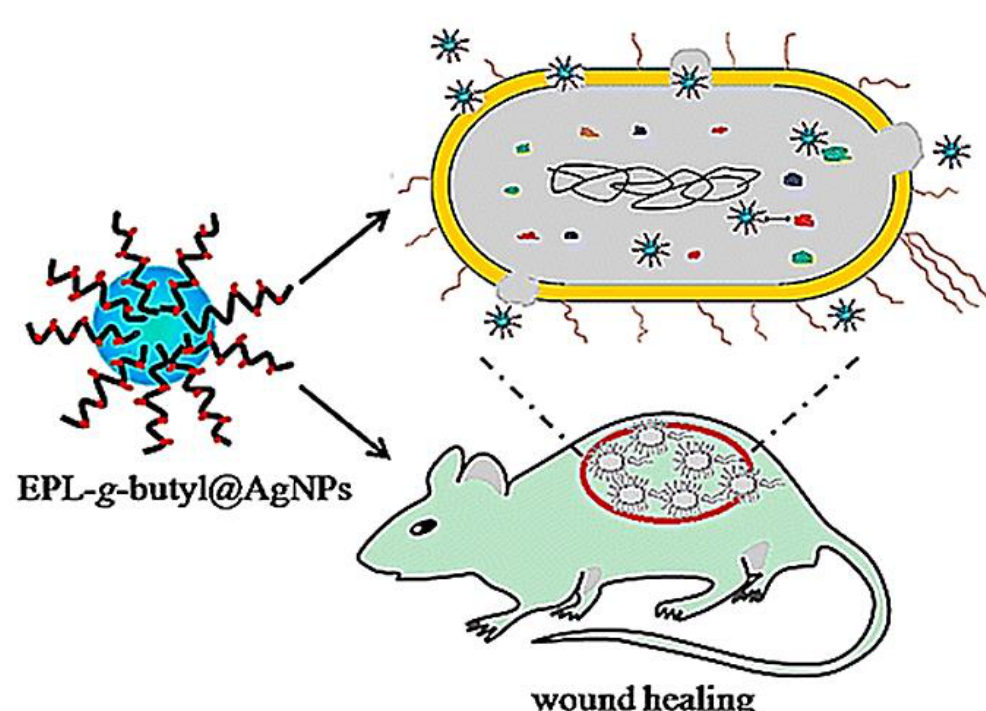
Figure 6. Nanocomposite (EPL- g -butyl@AgNPs) shows e ff ective antibacterial activity against both Gram-negative ( P. aeruginosa ) and Gram-positive ( S. aureus ) bacteria without the emergence of bacterial resistance, which e ff ectively promoted infected wound healing in diabetic rats. Reproduced from [124], with permission from American Chemical Society, 2016.